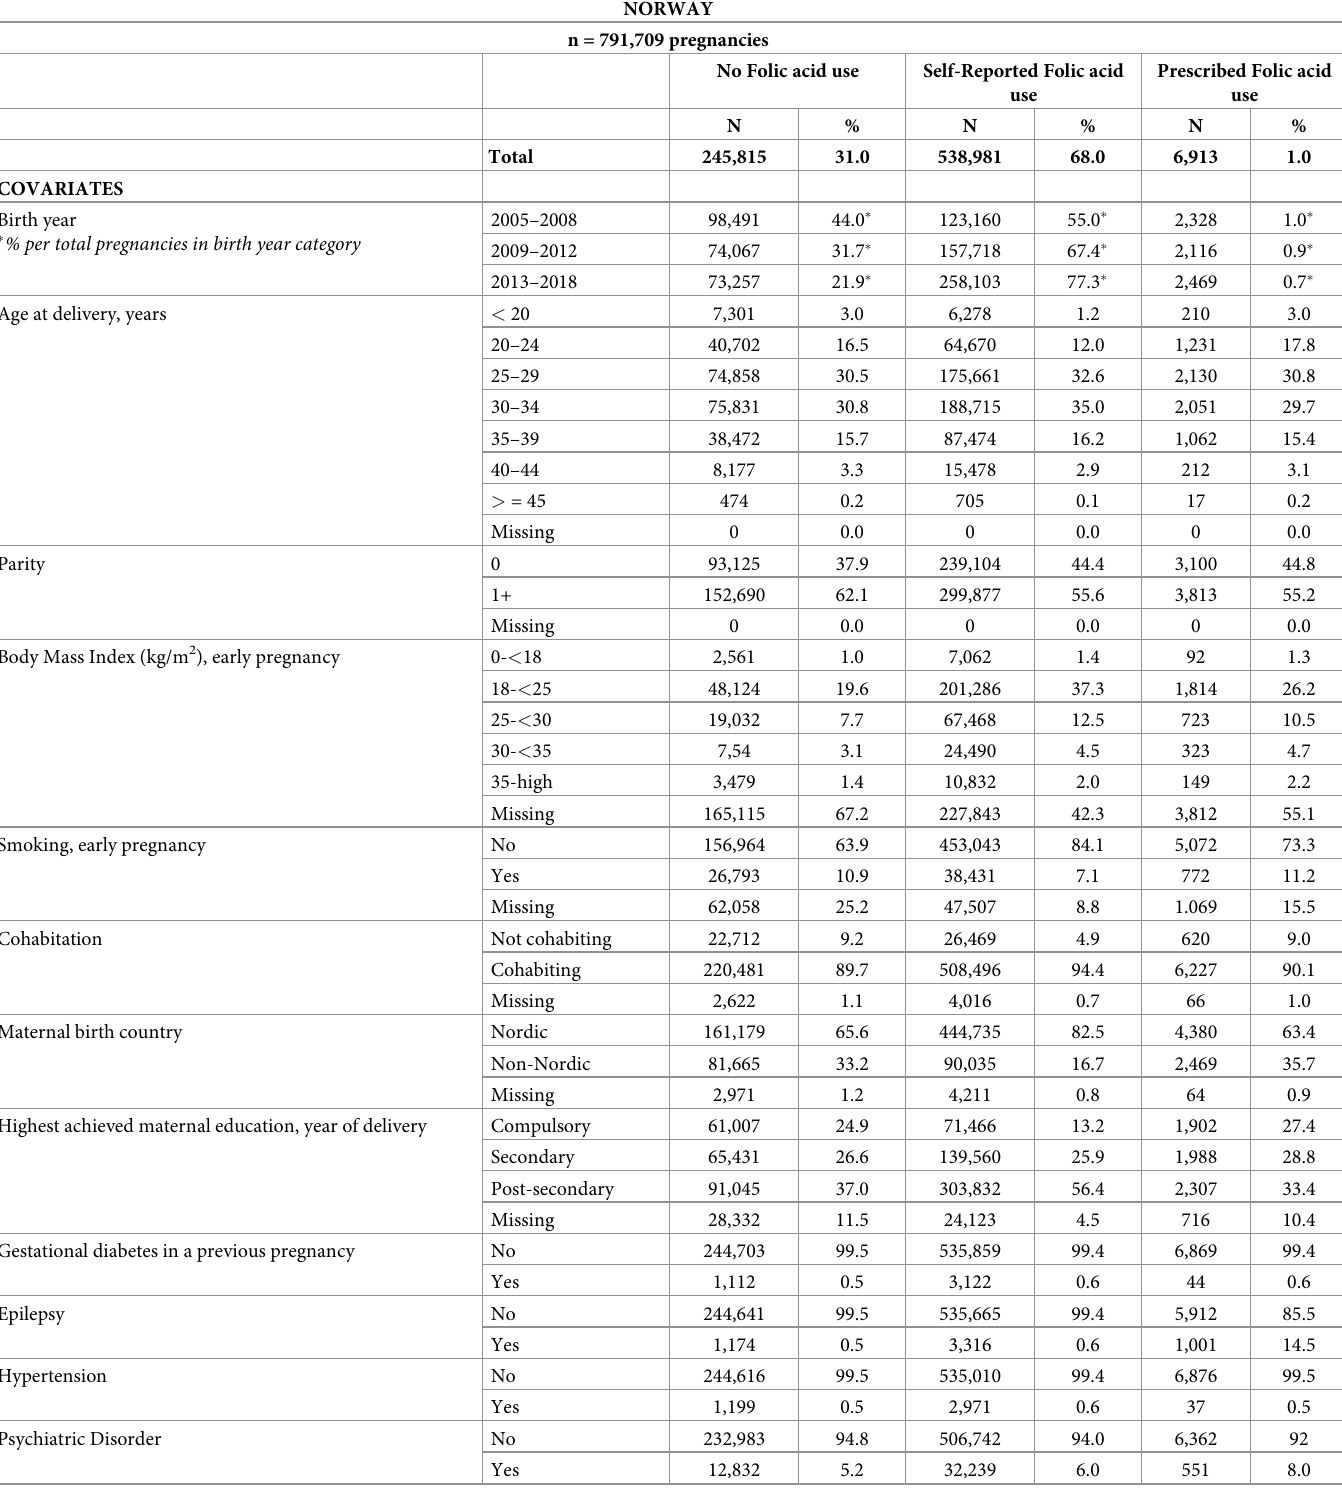
Table 1. Characteristics of study population from Norway including all pregnancies recorded in the Medical Birth Register from mothers without pre-existing dia- betes or pre-pregnancy antidiabetic medication use from 2005 to 2018.